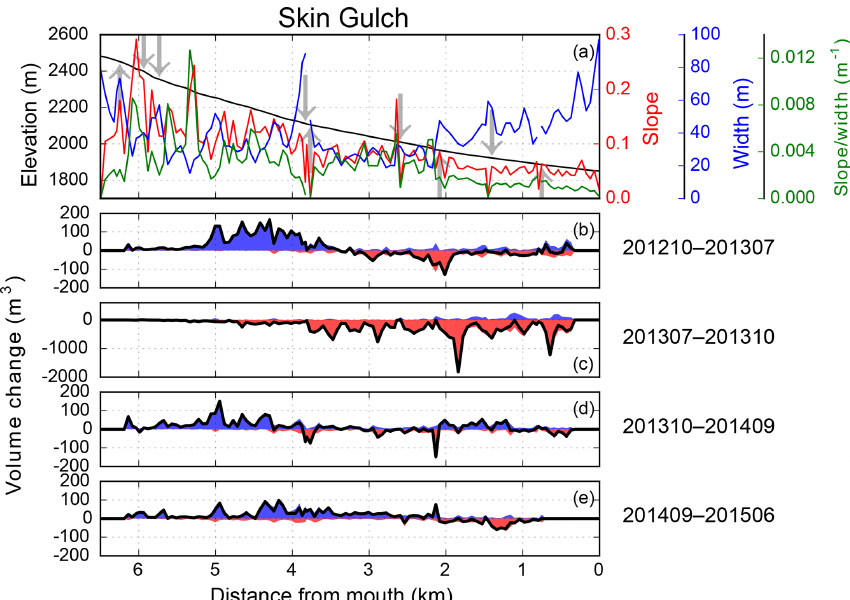
Figure 8. Longitudinal distributions in Skin Gulch of (a) elevation, channel slope, valley width and slope / width, and the corresponding longitudinal changes in volumes for (b) T1 (201210–201307), (c) T2 (201307–201310), (d) T3 (201310–201409), and (e) T4 (201409– 201506). Up and down arrows in (a) represent tributaries that enter the main channel from the right and left, respectively. Blue and red areas in (b) – (e) are deposition and erosion, respectively, and the black line is net volume change. Removal of excess sediment and restoration activities means that the data for the lowest 400m were excluded for all time periods, and for the lowest 700m in (e) . See Fig. 1 for the location of the reaches being represented, and the data in (a) were taken from the 201310 lidar dataset.